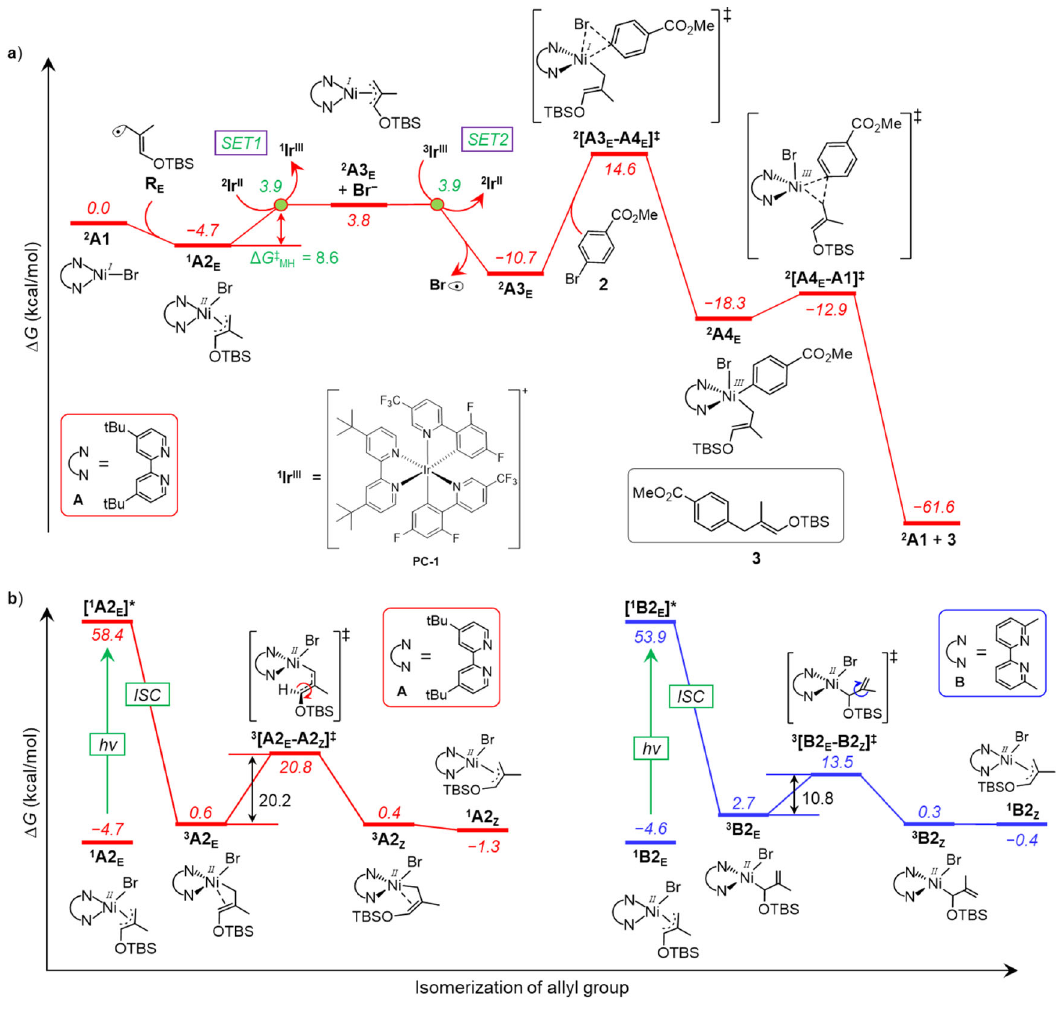
Fig. 7 | DFT calculated reaction energy pro fi le. a Free-energy pro fi le of Ni- catalytic cycle in the presence of dtbbpy ligand for E -product ( 3 ) formation. The M06(SMD-THF)/def2-TZVPP//PBE/def2-SVP/def2-TZVP level of theory was used to